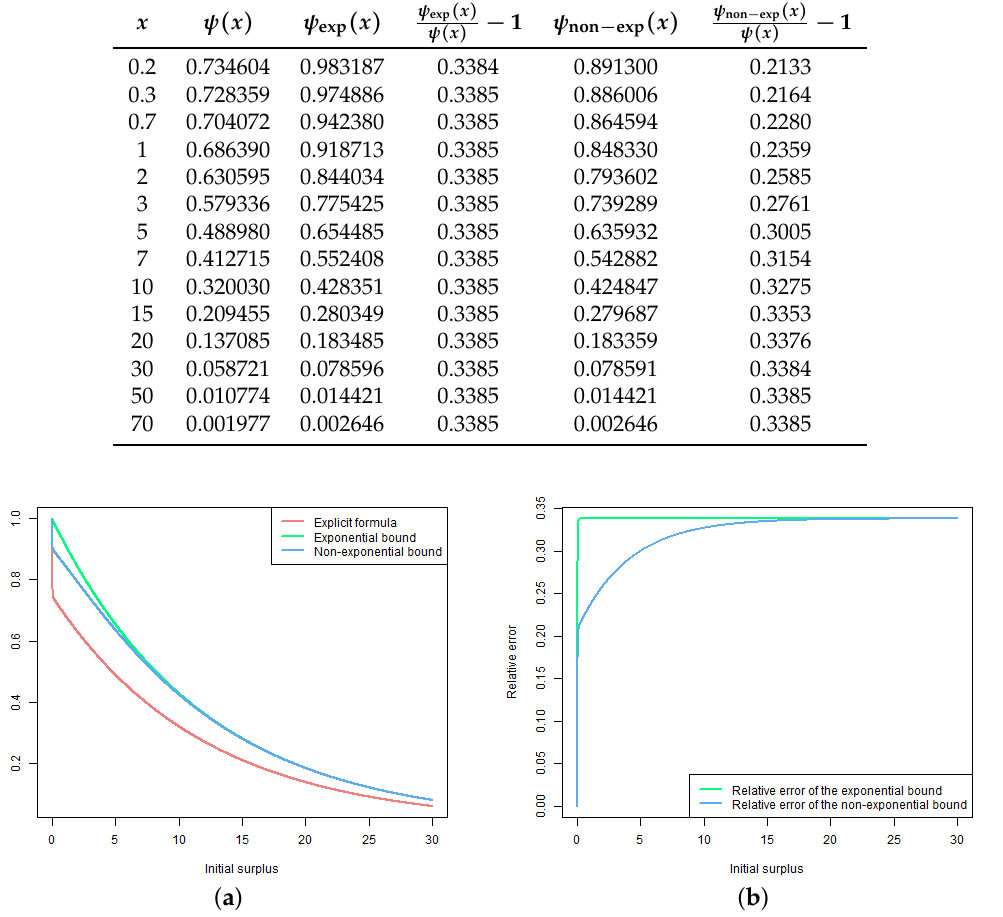
Figure 1. Comparison of the results for the model considered in Example 1: ( a ) Ruin probability given by the explicit formula as well as the exponential and non-exponential bounds for it. ( b ) Relative errors of the exponential and non-exponential